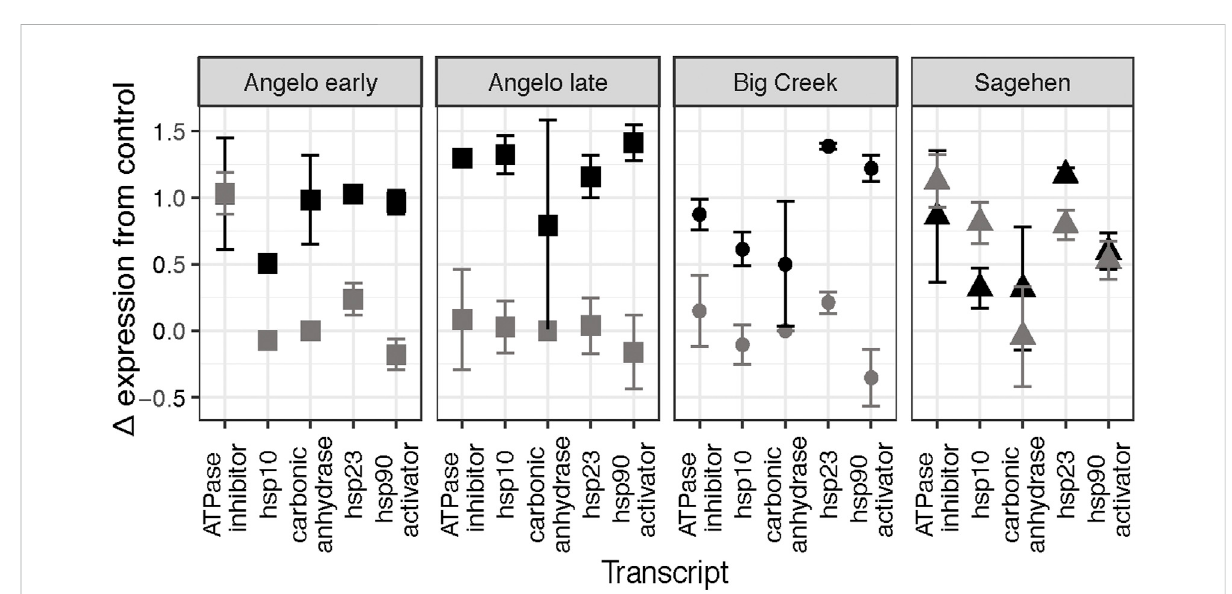
FIGURE 4 Change in expression relative to the control treatment for the fi ve genes clustered in the box in Figure 3B for each site. The daily warming treatment is represented in gray, and the heat shock treatment is represented in